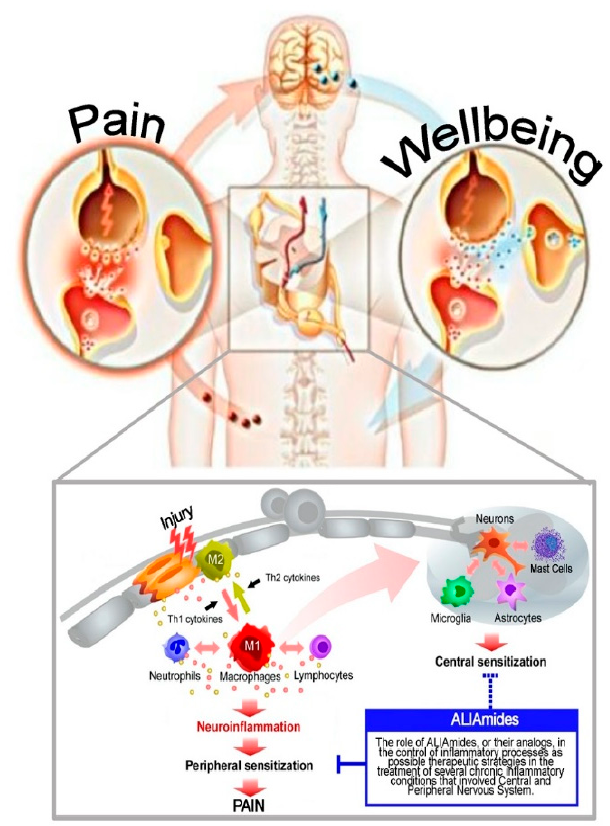
Figure 2. E ff ects of ALIAmides in attenuating Figure 2. Effects of ALIAmides in attenuating pain.